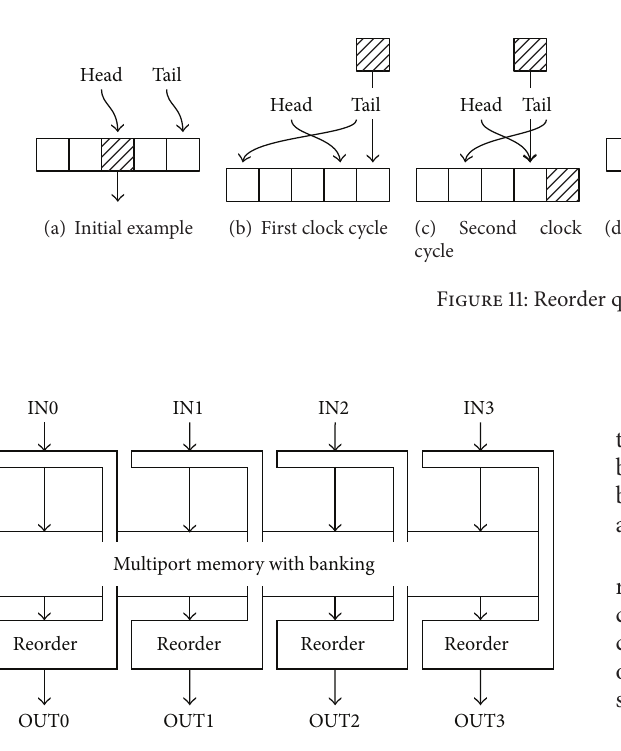
Figure 12: A reorder queue tags incoming read requests with an ID (which is the address into the reorder queue memory); this allows the reorder queue to correct the order of the read